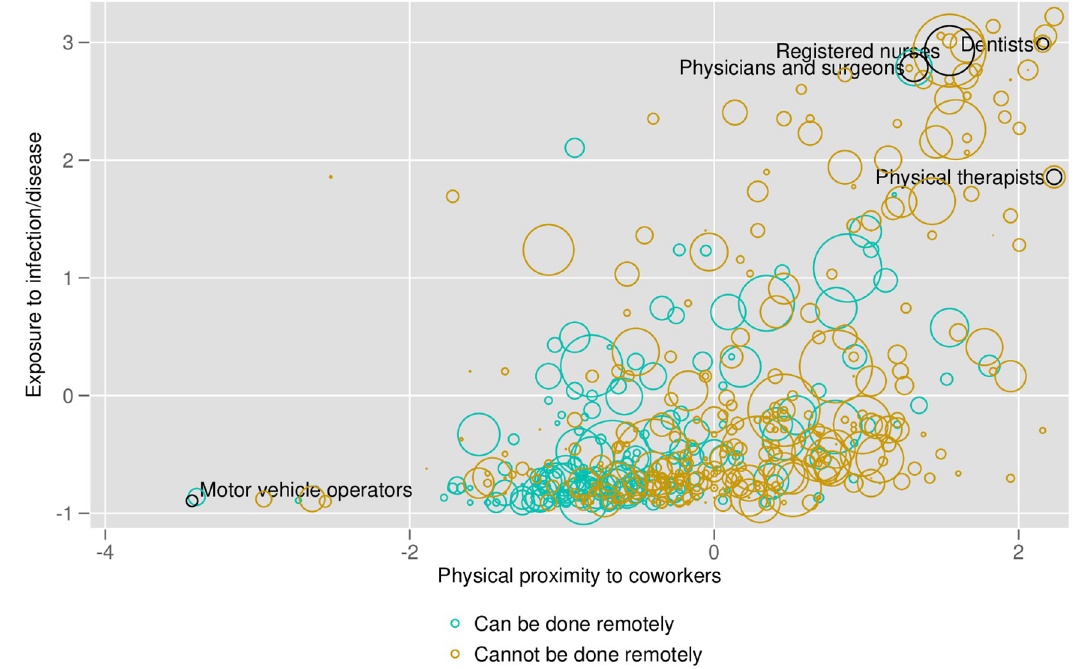
Fig 1. Physical proximity, exposure to the disease and remote work by occupation. Notes: Each circle represents an occupation. The size of each circle represents the number of CPS respondents employed in that occupation–the larger the circle, the greater the number of people employed in that occupation. The x-axis plots each occupation’s physical proximity to coworkers, measured by O � NET’s index. The further to the right, the closer in proximity employees in that occupation work with their coworkers. The y-axis plots each occupation’s exposure to infection and disease, also measured by O � NET’s index. The further up, the more frequently employees in that occupation are exposes to infection and disease. The color of the circles corresponds to the whether or not the occupation can be performed remotely via